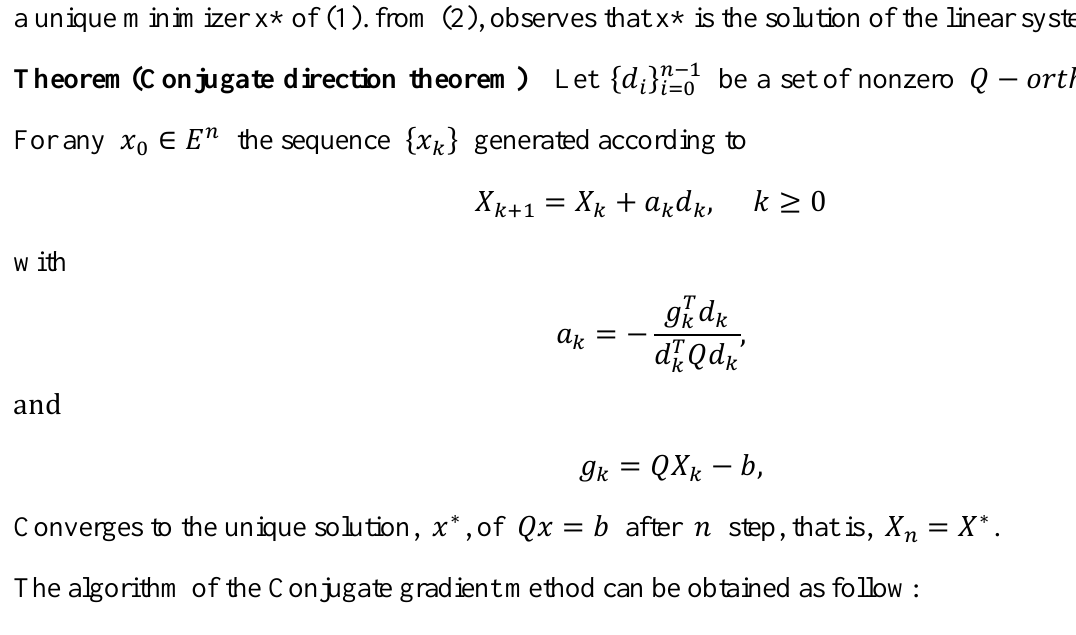
Algorithm 2. Conjugate gradient